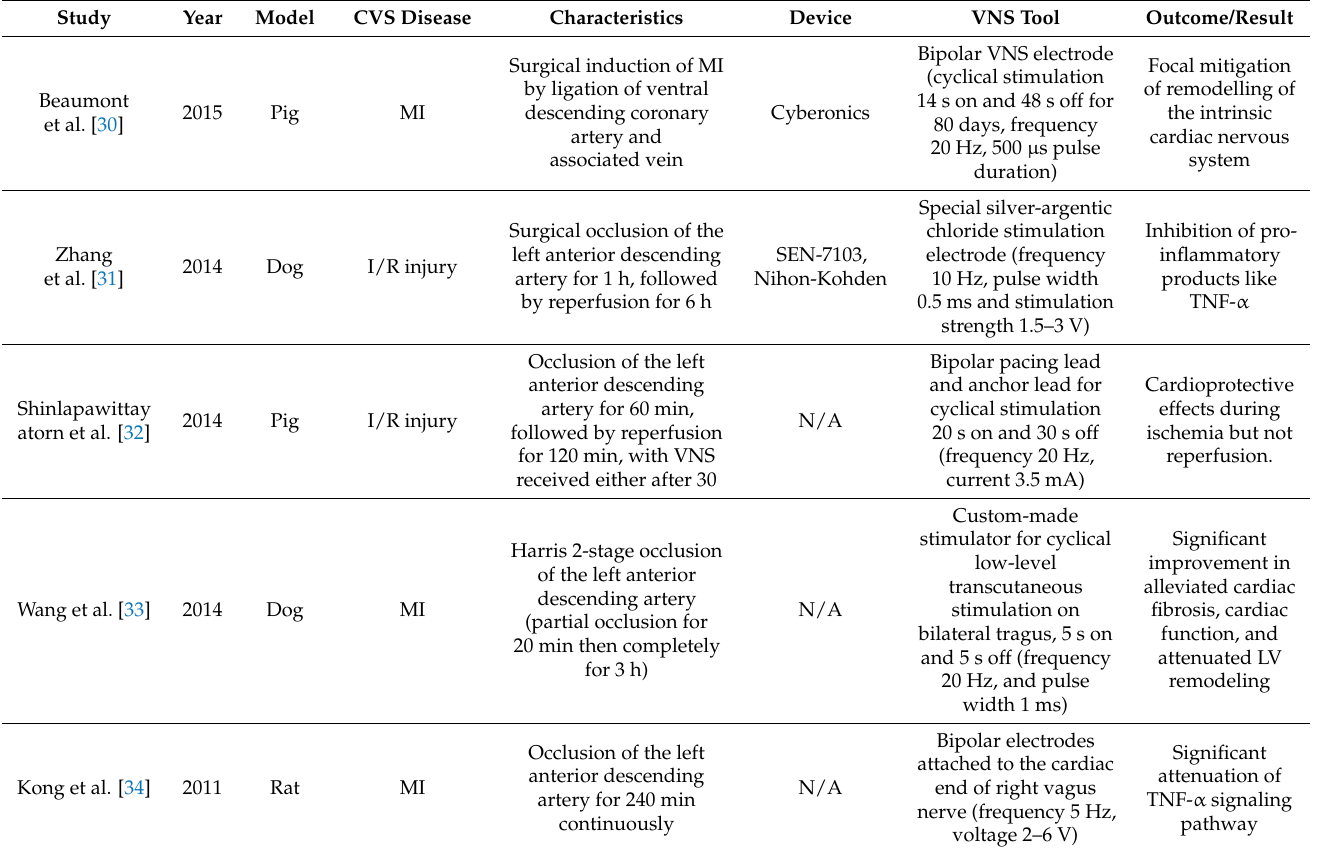
Table 2. Studies on VNS usage for atrial fibrillation (AF), ventricular fibrillation (VF), and heart